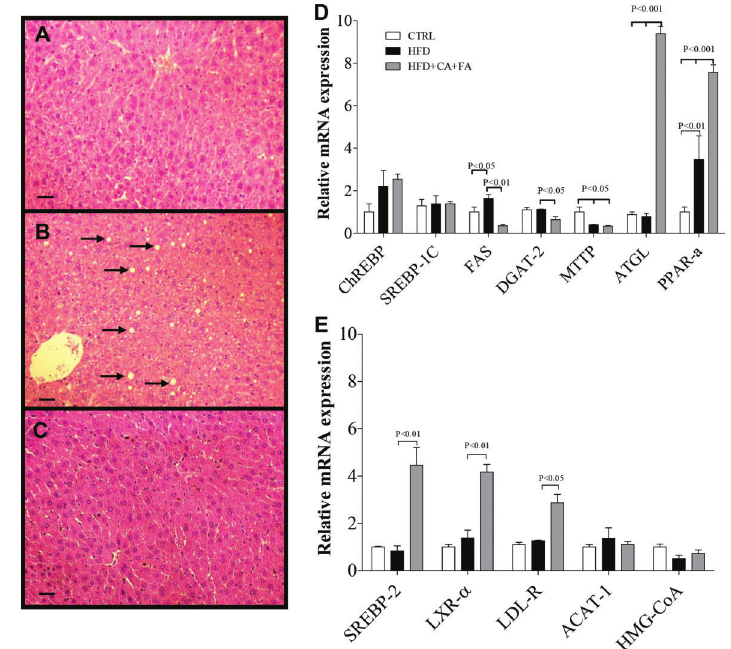
Table 2. Cholesterol and triglycerides plasma levels of mice fed with chow diet (Control), high-fat diet (HFD), and HFD with combined treatment of caffeic